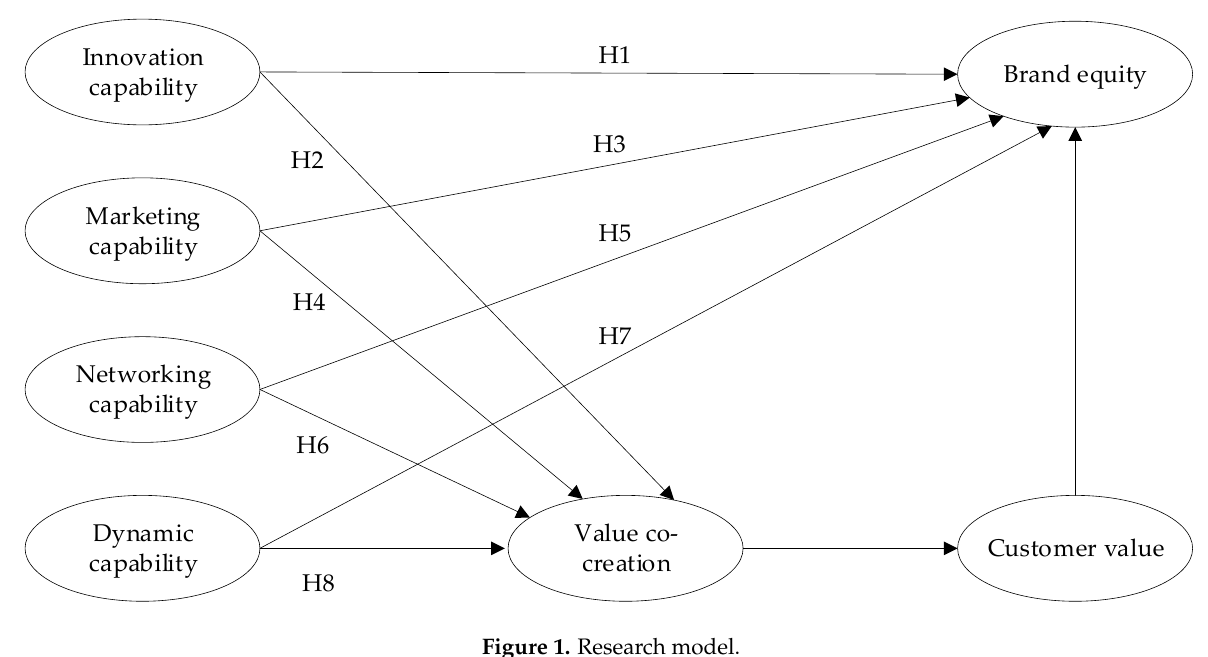
Figure 1. Research model.